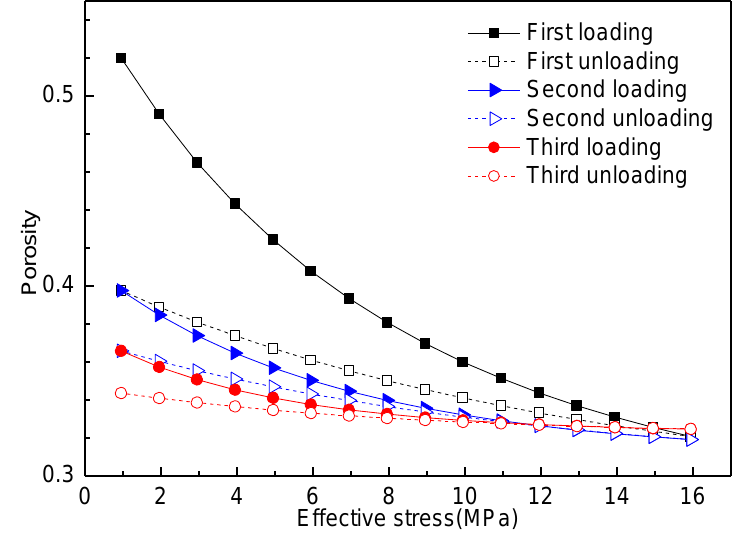
Figure 12. Changes of porosity of coal samples under cyclic loading and unloading conditions.